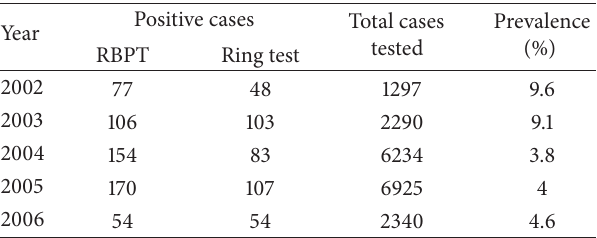
Table 3: Brucellosis prevalence in cattle for a period of 5 years in the Kabutare veterinary school’s